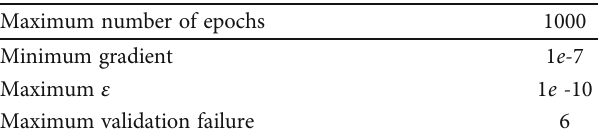
Table 1: Training stop criteria. Table 2: Factors of the DOE for the proposed